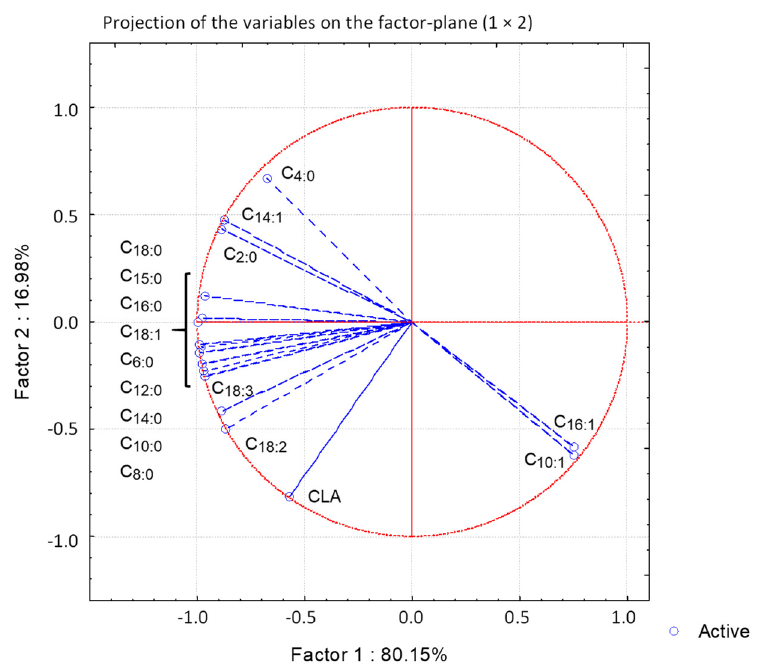
Figure 2. Principal component analysis for free fatty acids in Zamorano cheese after 240 days’ ripening as a function of breed through the representation of projections. Table 4. Average values for texture parameters in Zamorano cheese made with milk from Churra (Ch) and Assaf (A) breed after 240 days’